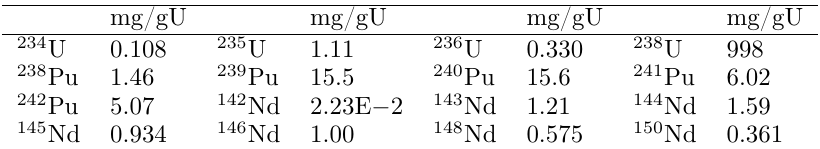
Table B.2. Measured concentrations for the BM3 sample (from PSI), after mass balance adjustment. No experimental uncertainties are